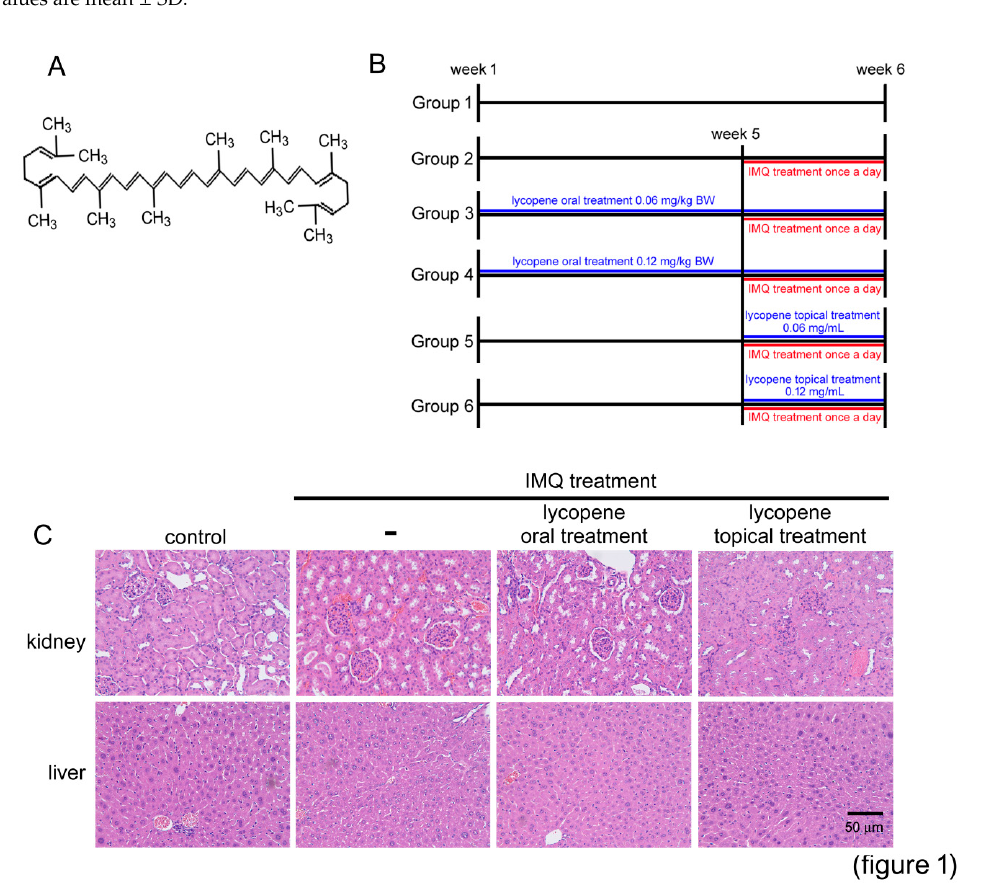
Figure 1. Lycopene treatment did not affect liver and kidney function. ( A ) The molecular structure